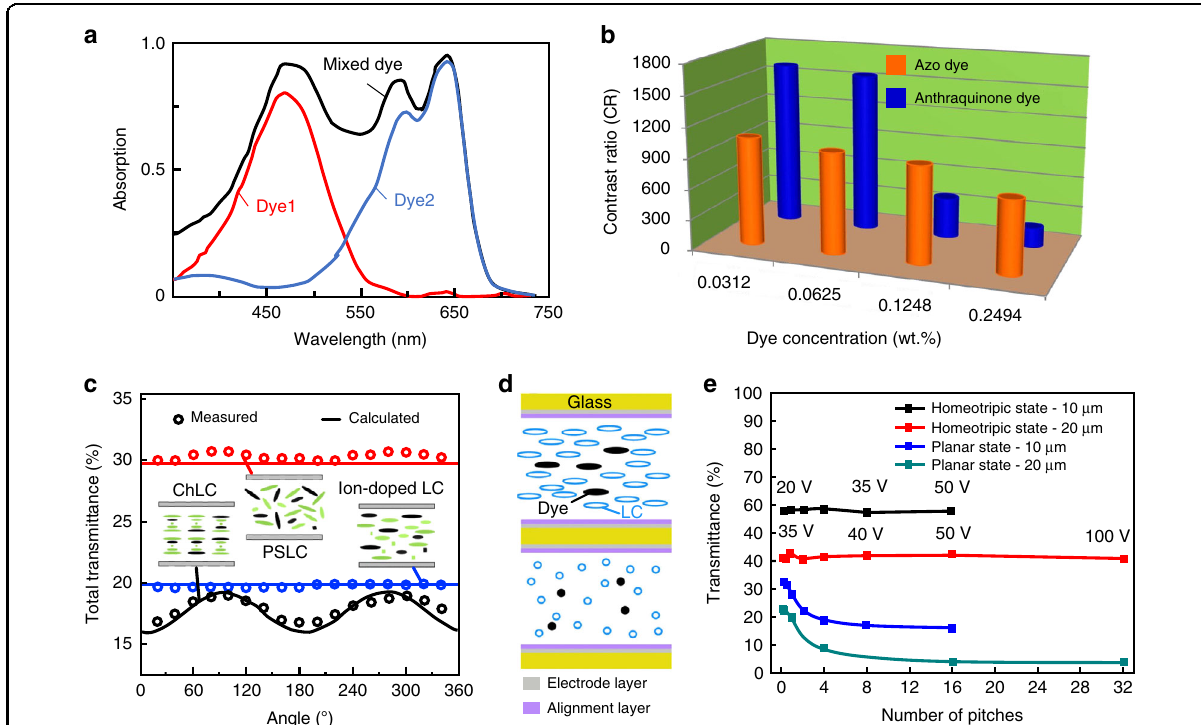
Fig. 6 Switchable optical devices doped with dichroic dyes. a Absorption spectra of mixed and single dyes. b Switching contrast coef fi cient (CR) of PDLC doped with different concentrations of azo/anthraquinone dichroic dyes. Reproduced with permission from ref. 82 . Copyright 2018, Elsevier. c Cross-polarization structure of double-layer cells. Reproduced with permission from ref. 86 . Copyright 2018, Elsevier. d Transmittance of dye-doped LC devices with different alignments where doping had the strongest light absorption properties in Ch-LC. Adapted with permission from ref. 87 . Copyright 2019, Optica Publishing Group. e The measured and calculated transmittances in the planar state vs. the number of pitches. Reproduced with permission from ref. 88 . Copyright 2013, Optica Publishing